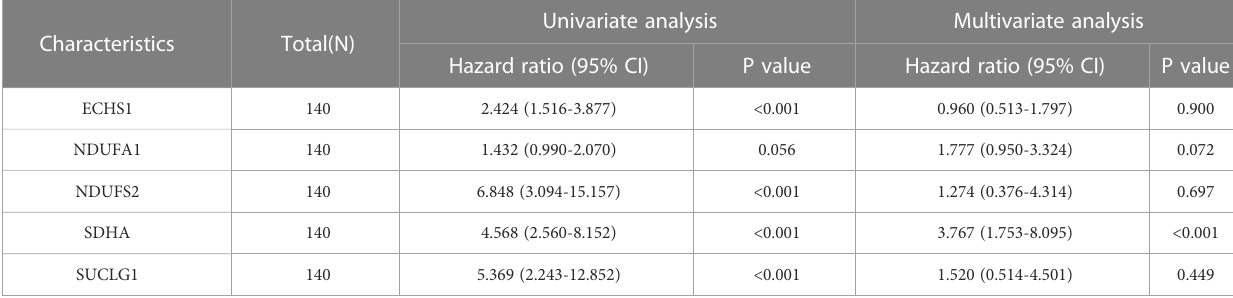
TABLE 2 Cox regression to prognosis MMRGs associated with OS in